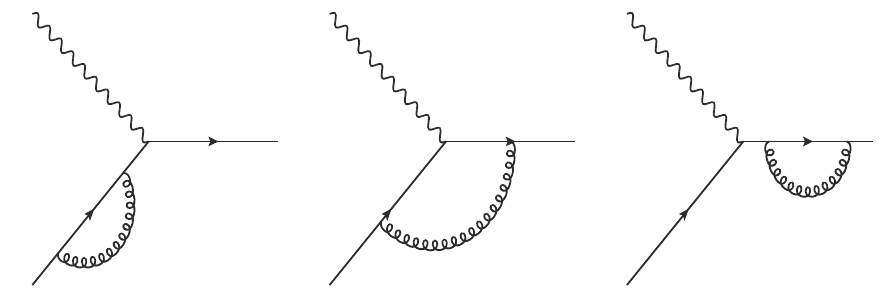
Figure 2: The NLO virtual correction diagrams in